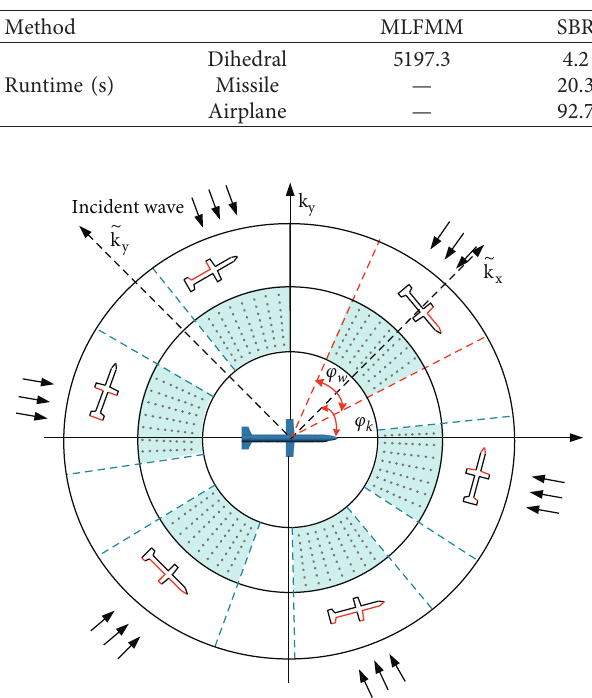
Figure 7: Illustration of multiview ISAR.